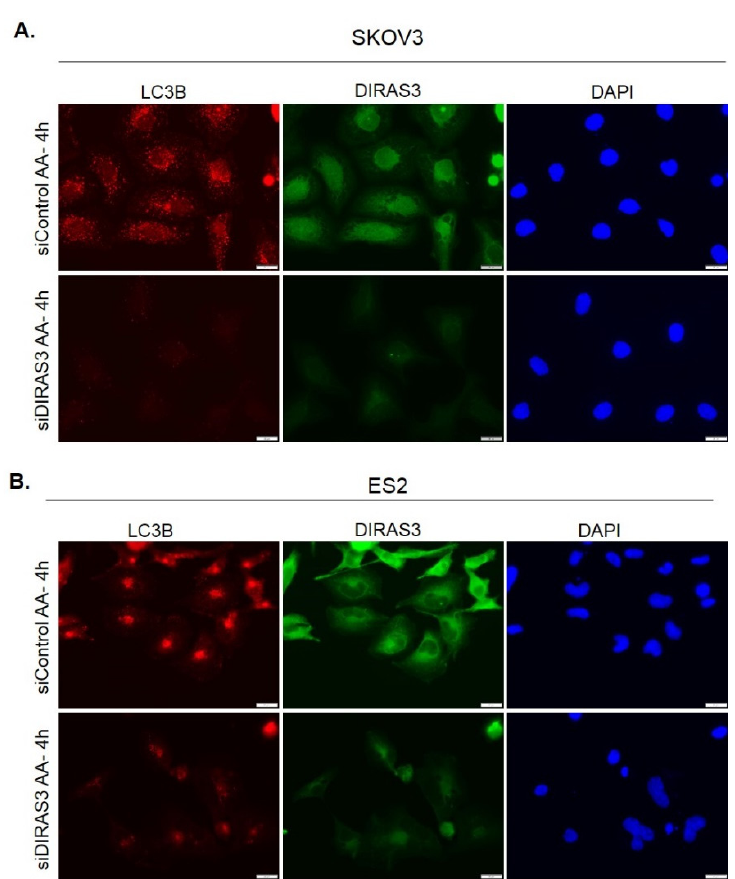
Figure A1. Knockdown of DIRAS3 inhibits starvation-induced autophagy. SKOV3 ( A ) or ES2 ( B ) ovarian cancer cells were treated with either control siRNA or siRNA directed at DIRAS3 for 72 h prior to undergoing amino acid deprivation for 4 h. Immunofluorescence staining was performed and LC3B puncta, DIRAS3 expression and DAPI nuclear staining were visualized. Representative images are shown for each condition. Scale bars indicate 20 μ m.